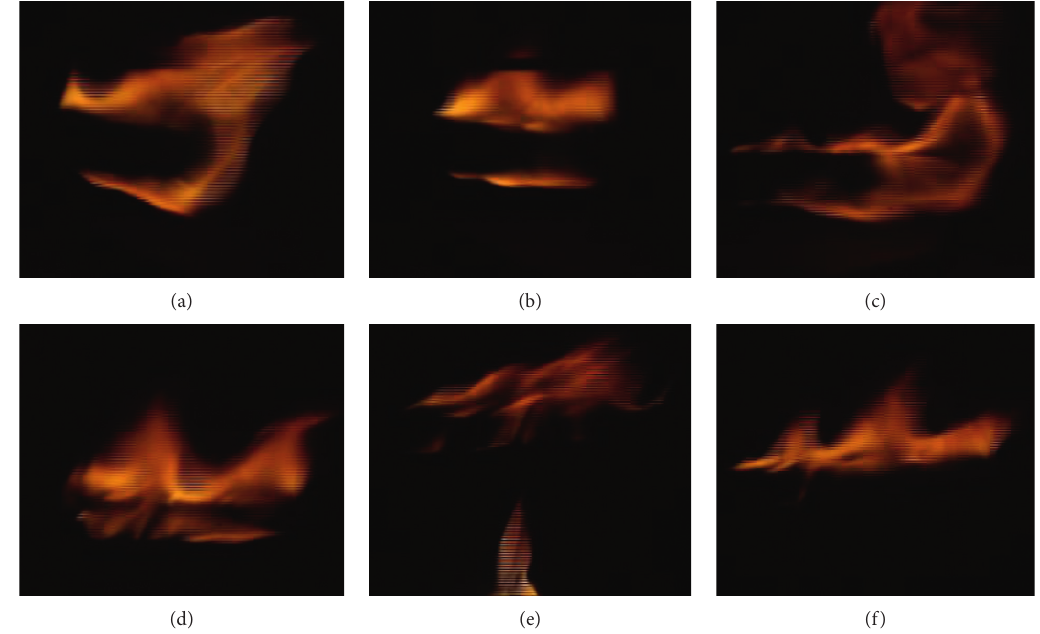
Figure 8: Images of a single cable flame spread at a fan frequency of 11Hz. (a) t � 129s, (b) t � 131 s, (c) t � 311s, (d) t � 1205s, (e) t � 1244s, and (f) t �